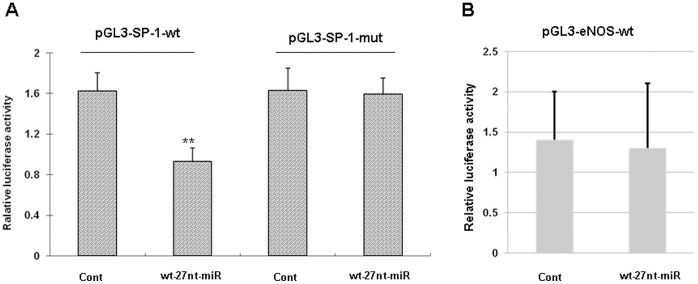
Sp-1 is a direct target of 27-nt-miRNA.(A) Luciferase-reporter plasmids were constructed by inserting the wt (5′-TCACCCC-3′, pGL3-SP1-wt)or mutant (5′-TGTGCCC-3′, pGL3-SP1-mut) segment of SP-1 mRNA containing 27nt-miRNA-matched sequence. (B) Luciferase-reporter plasmids were constructed by inserting the eNOS sequence into the vector. The wt or mutant reporter plasmid was co-transfected into normal endothelial cells along with 27 miRNA or negative control. The normalized luciferase activity in the control group was set as relative luciferase activity. All data are representative of three independent experiments. cont, cells transfected with control plasmid; wt-27nt-miR, cells transfected with plasmid expressing wild-ytpe 27-nt-miRNA. **, P<0.01 vs control (n = 3).